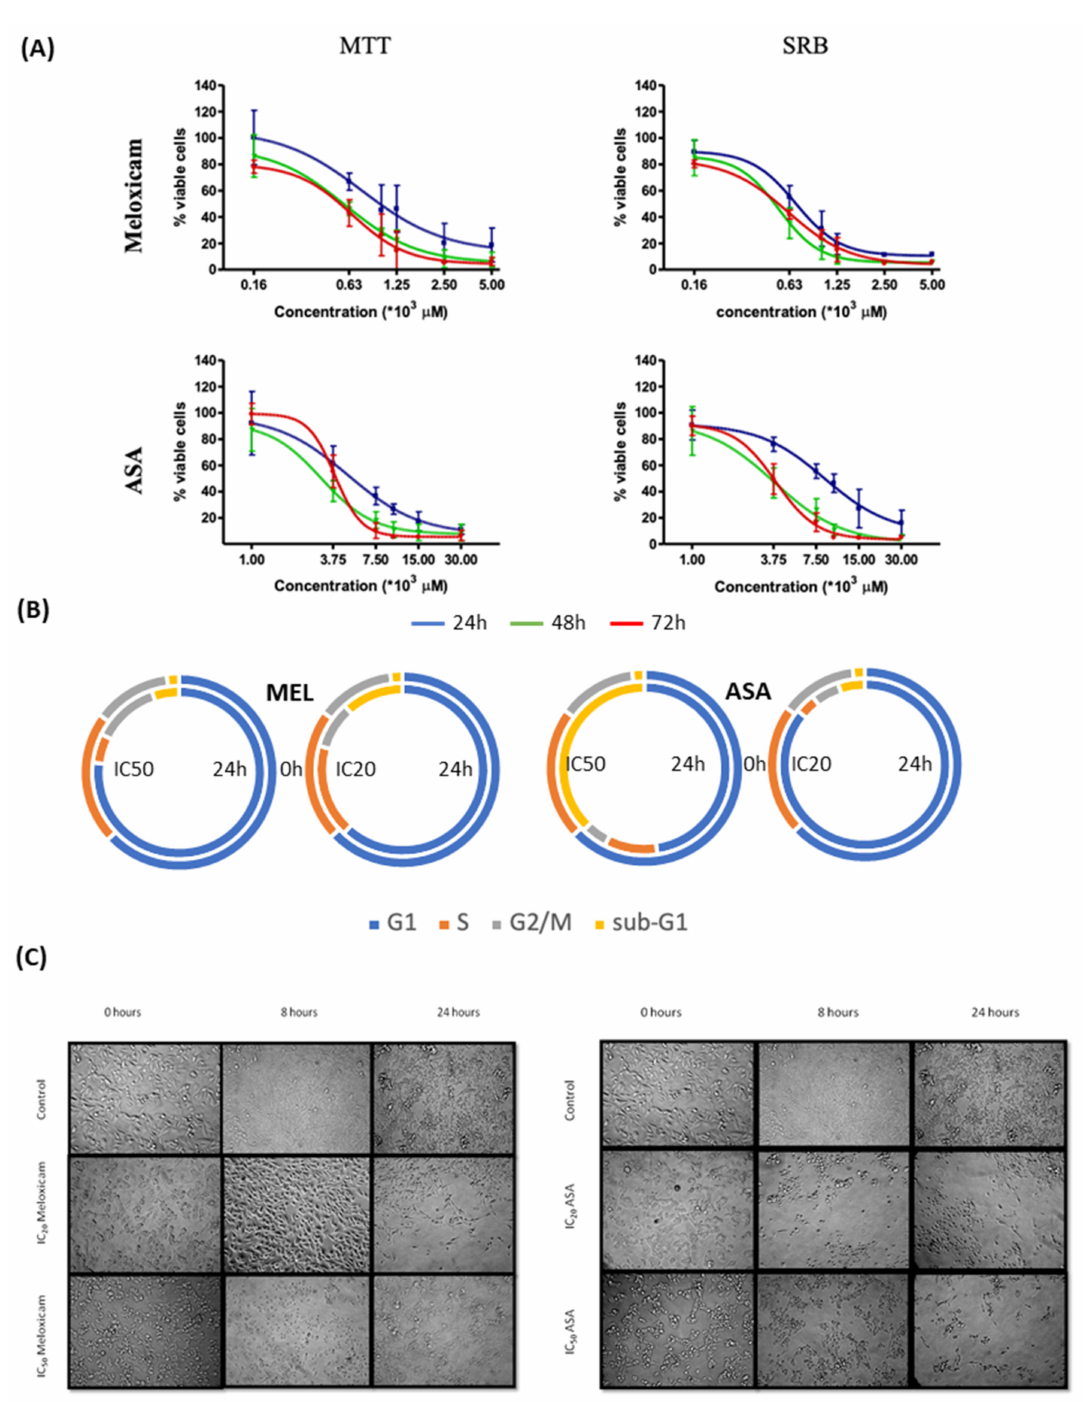
Figure 4. Effects of meloxicam and aspirin (ASA) on proliferation, mitochondrial viability and morphology of B16F10 cells. ( A ) Mitochondrial viability (MTT assay) and antiproliferative (SRB assay). ( B ) Cell cycle distribution (%) after 24 h incubation with IC 20 and IC 50 of the inhibitors. ( C ) Cell morphology of treated cells. Values are the mean of three independent assays. Error bars represent